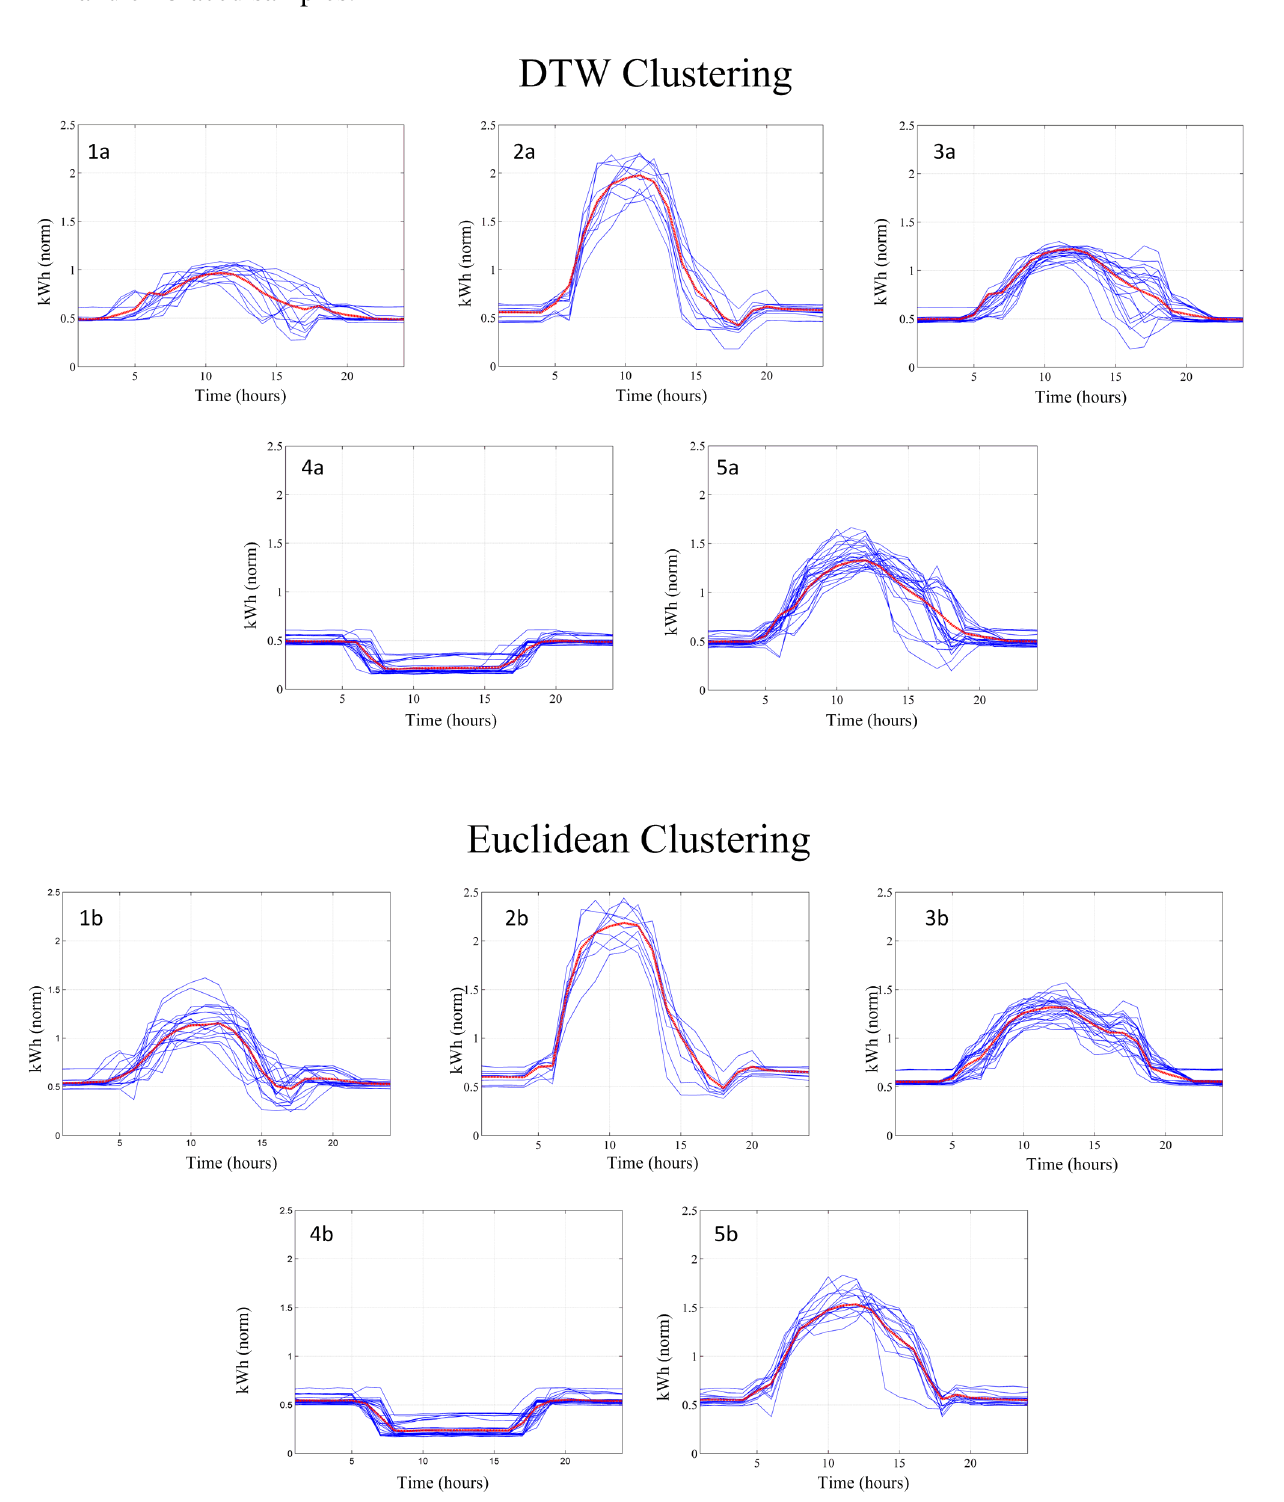
Figure 7. Patterns discovered using DTW and Euclidean measures in “Rectorat” building, and embraced